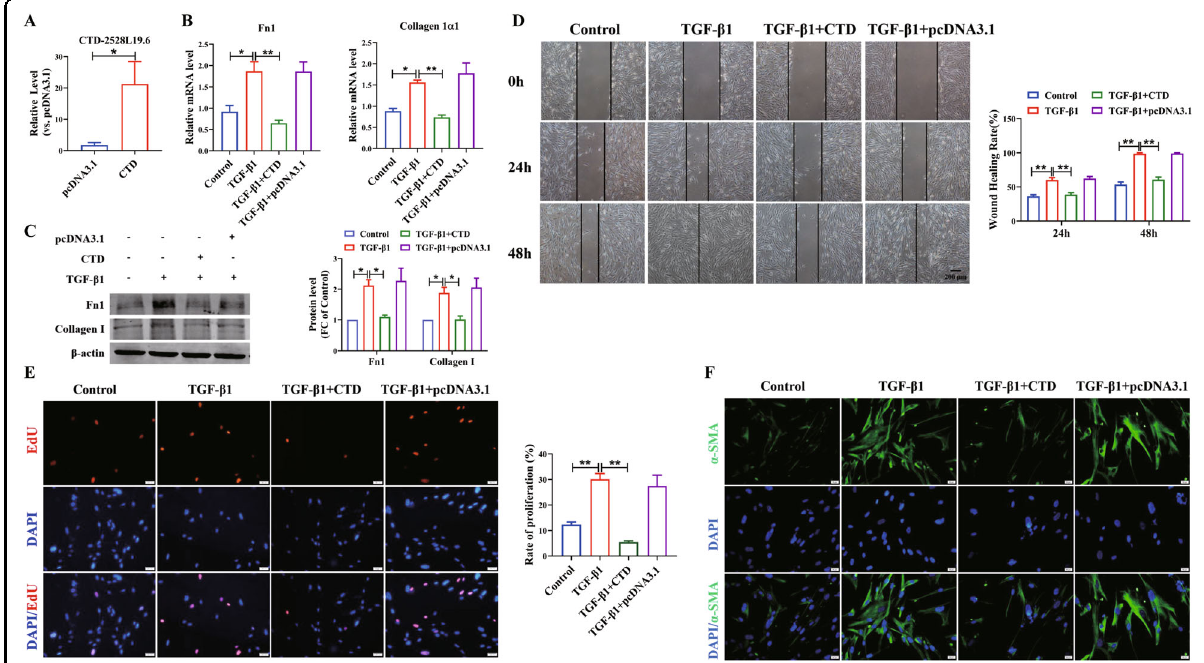
Fig. 7 LncRNA CTD - 2528L19 .6 inhibits the TGF- β 1-induced fi broblast activation in MRC-5 cells. qRT-PCR analysis of the expression of CTD - 2528L19 .6 ( A ) and Fn1, Collagen 1 α 1 ( B ) in MRC-5 cells after transfection CTD - 2528L19 .6 under TGF- β 1 induced fi broblast activation. n = 4. C Western blot results demonstrate that the overexpression of CTD - 2528L19 .6 inhibits the pro- fi brotic effect of TGF- β 1 in MRC-5. n = 9. Wound-healing assay ( D ) and EdU proliferation assay ( E ) reveals the inhibitory effects of CTD - 2528L19 .6 on TGF- β 1-induced migration and proliferation in MRC-5 cells. n = 4. Scale bars, 200 μ m in D and 50 μ m in E . F Fibroblast to myo fi broblast transition was observed by immuno fl uorescence. Scale bar, 20 μ m. * P < 0.05; ** P <